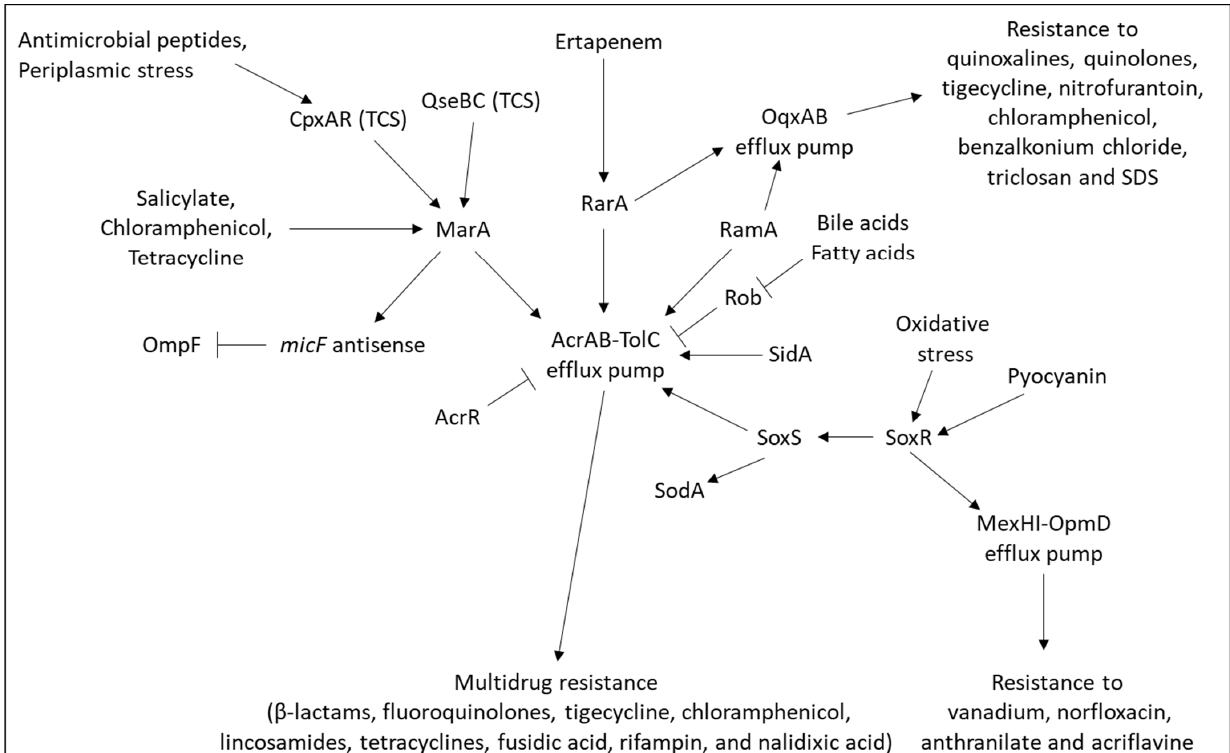
Figure 5. Regulation of AcrAB-TolC efflux pump expression in Gram-negative bacteria. The expression of AcrAB-TolC, which confers multidrug resistance, is regulated by several transcriptional regulators including MarA, RarA, RamA, Rob, AcrR, SidA, and SoxS. MarA, in turn, is regulated by the TCSs CpxAR and QseBC, as well as various antibiotics. MarA reduces the expression of the OmpF porin which is required for the penetration of several antibiotics into the bacteria. RarA is activated by the antibiotic ertapenem. Besides upregulating AcrAB-TolC, RarA increases the expression of the OqxAB multidrug efflux pump. Bile acids and fatty acids increase AcrAB-TolC expression through repression of the Rob transcriptional regulator. SoxS is regulated by SoxR whose activity is influenced by oxidative stress, as well as by the Pseudomonas aeruginosa -produced pyocyanin pigment. In turn, SoxS increases the expression of SodA superoxide dismutase, which is a mechanism to protect the bacteria from oxidative stress. Additionally, SoxR induces the expression of the MexHI-OpmD efflux pump, thus conferring resistance to additional compounds.